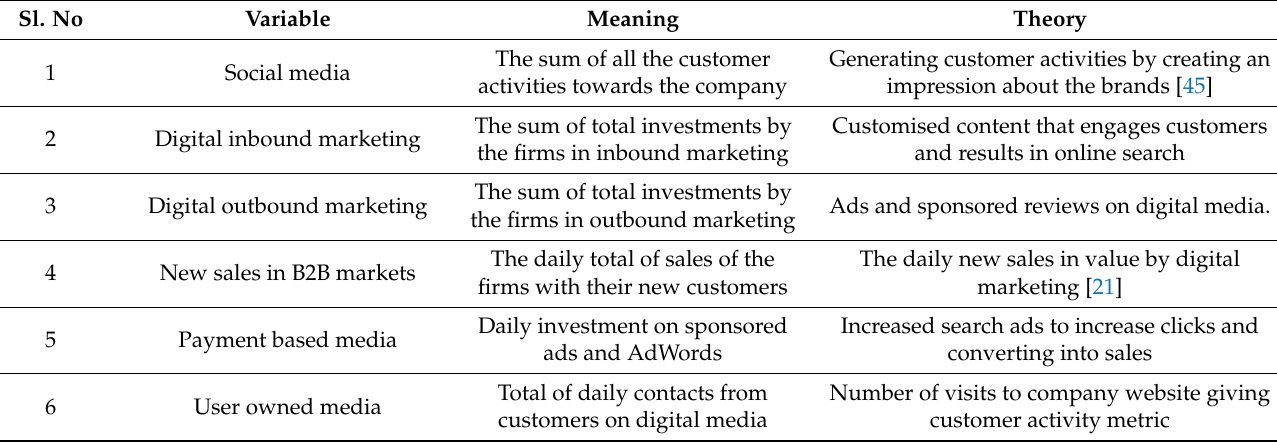
Table 1. Existing literature and variable